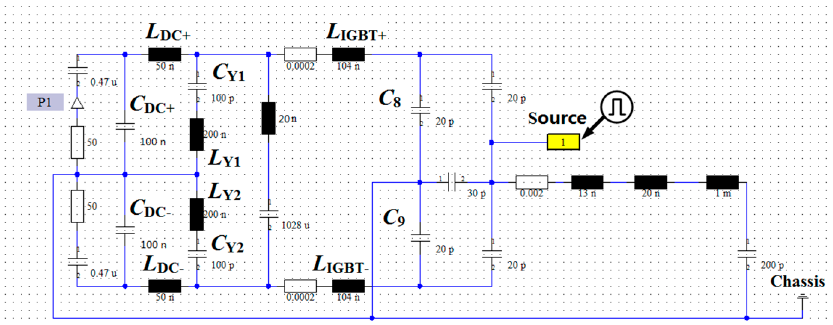
Figure 11. CM circuit model of single-arm bridge of power inverter.